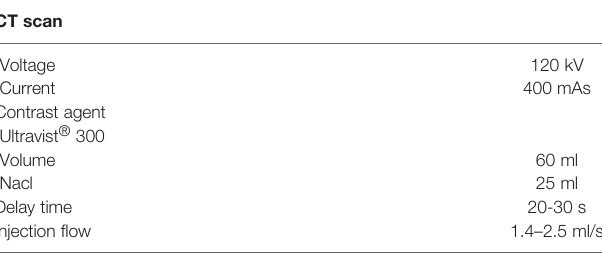
TABLE 2 | The computed tomography angiography principle.